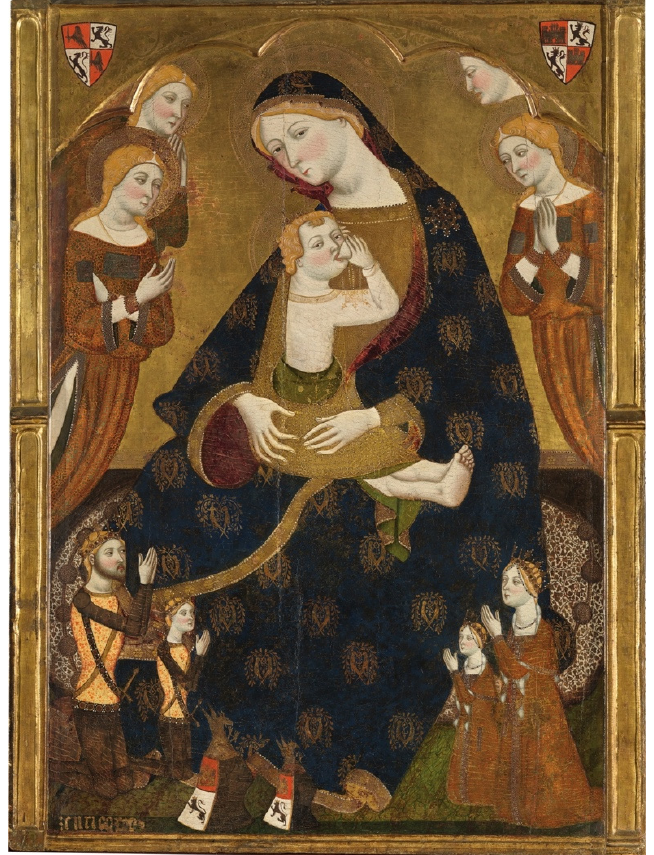
Figure 1. The Virgin of Tobed with donors Henry II of Castile, his wife Juana Manuel, and two of their children. Painting. 1367–1369/1375. Attributed to Jaume Serra. Prado Museum. © Image Bank of the Prado Museum.